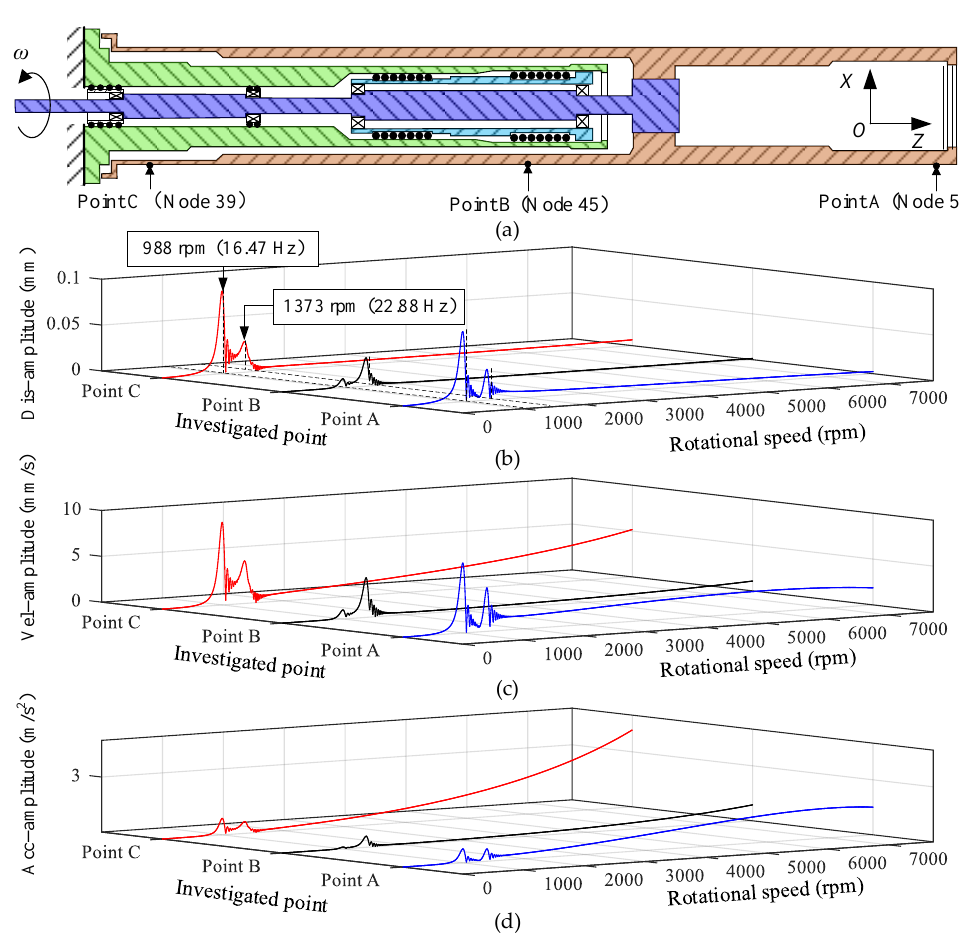
Figure 11. Dynamic response of different investigated points in the X direction under the speed-up time of 60 s. ( a ) Investigated points on the winding rotor; ( b ) displacement amplitude curve; ( c ) velocity amplitude curve; ( d ) acceleration amplitude curve.